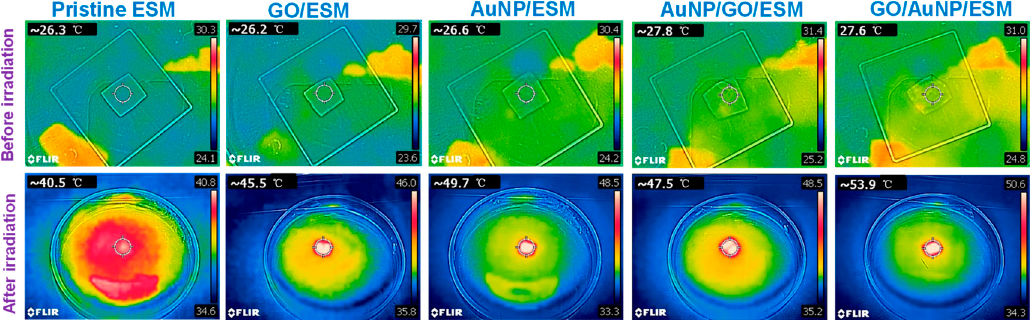
Figure 6. Infrared thermal images of different ESM samples before and after light irradiation for 10 min under xenon lamp.